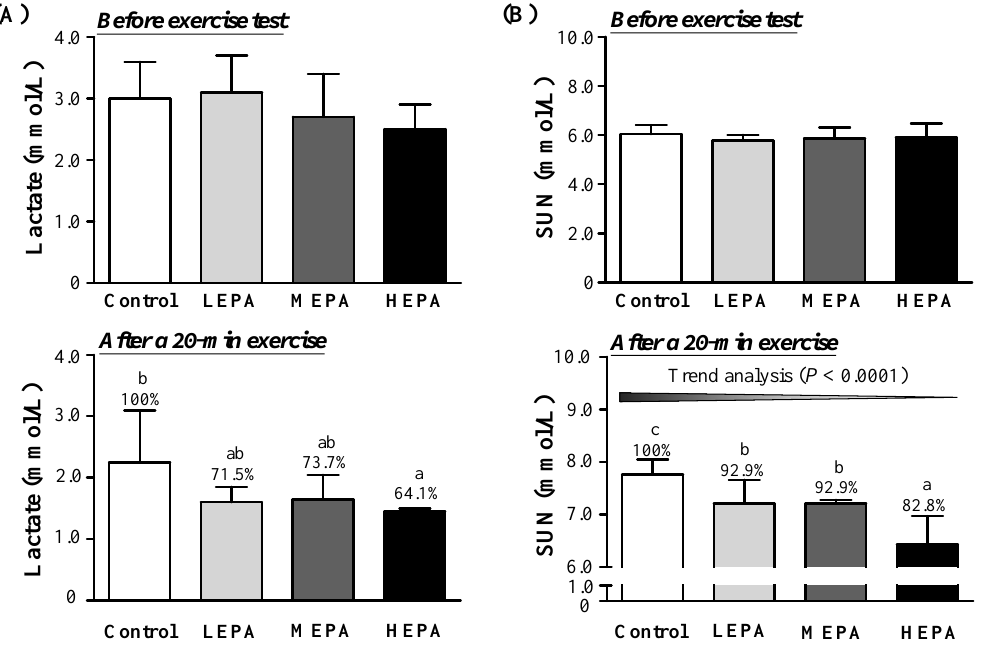
Figure 3. Effect of EPA on levels blood lactate ( A ) and serum urea nitrogen (SUN) ( B ) in rats before and after a single exercise challenge for 20 min. LEPA: low dose (75 mg/kg); MEPA: medium dose (150 mg/kg); HEPA: high dose (375 mg/kg). Data are mean ± SD ( n = 6 rats per group). Different letters (a, b, c) indicate significant difference at p < 0.05 by the Cochran-Armitage test for dose-effect trend.